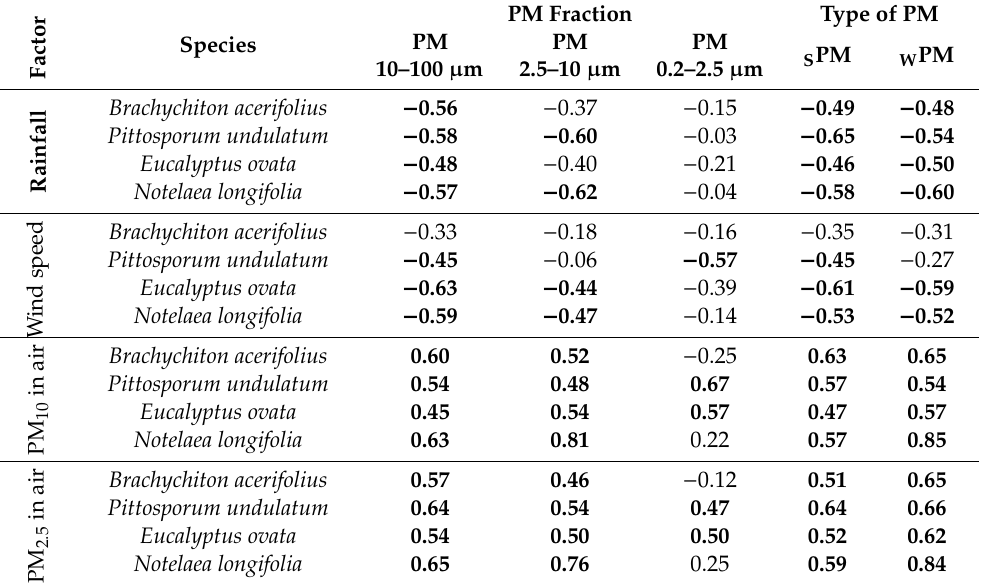
Table 1. Correlation coe ffi cients between meteorological conditions (rainfall and wind speed) and concentration of PM 10 and PM 2.5 in the air and the amount of PM (in three size fractions—fine, coarse and large—and the two types of PM— S PM and W PM) accumulating on leaves of four species of Australian trees. Results in bold are statistically